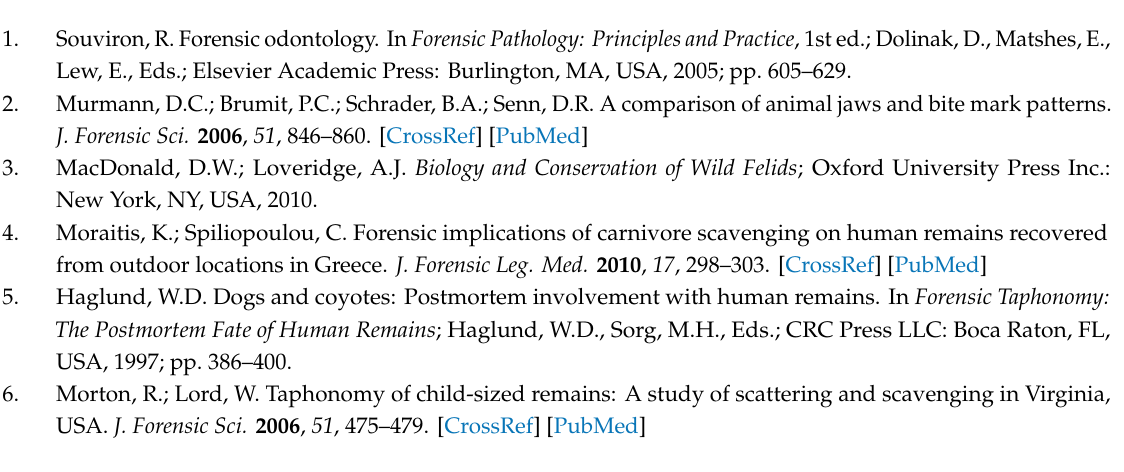
Figure S1: Boxplots for the dental measurements without the outlier values considering sex as a source of variation, Figure S2: 3D scatter PLS-DA plot. Sex di ff erentiation before the outlier female sample (green arrow) was excluded from the multivariate analysis, Table S1: Comparison of the mean values for the wolf sex di ff erentiation considering the existence or exclusion of the outlier values present only in seven specific